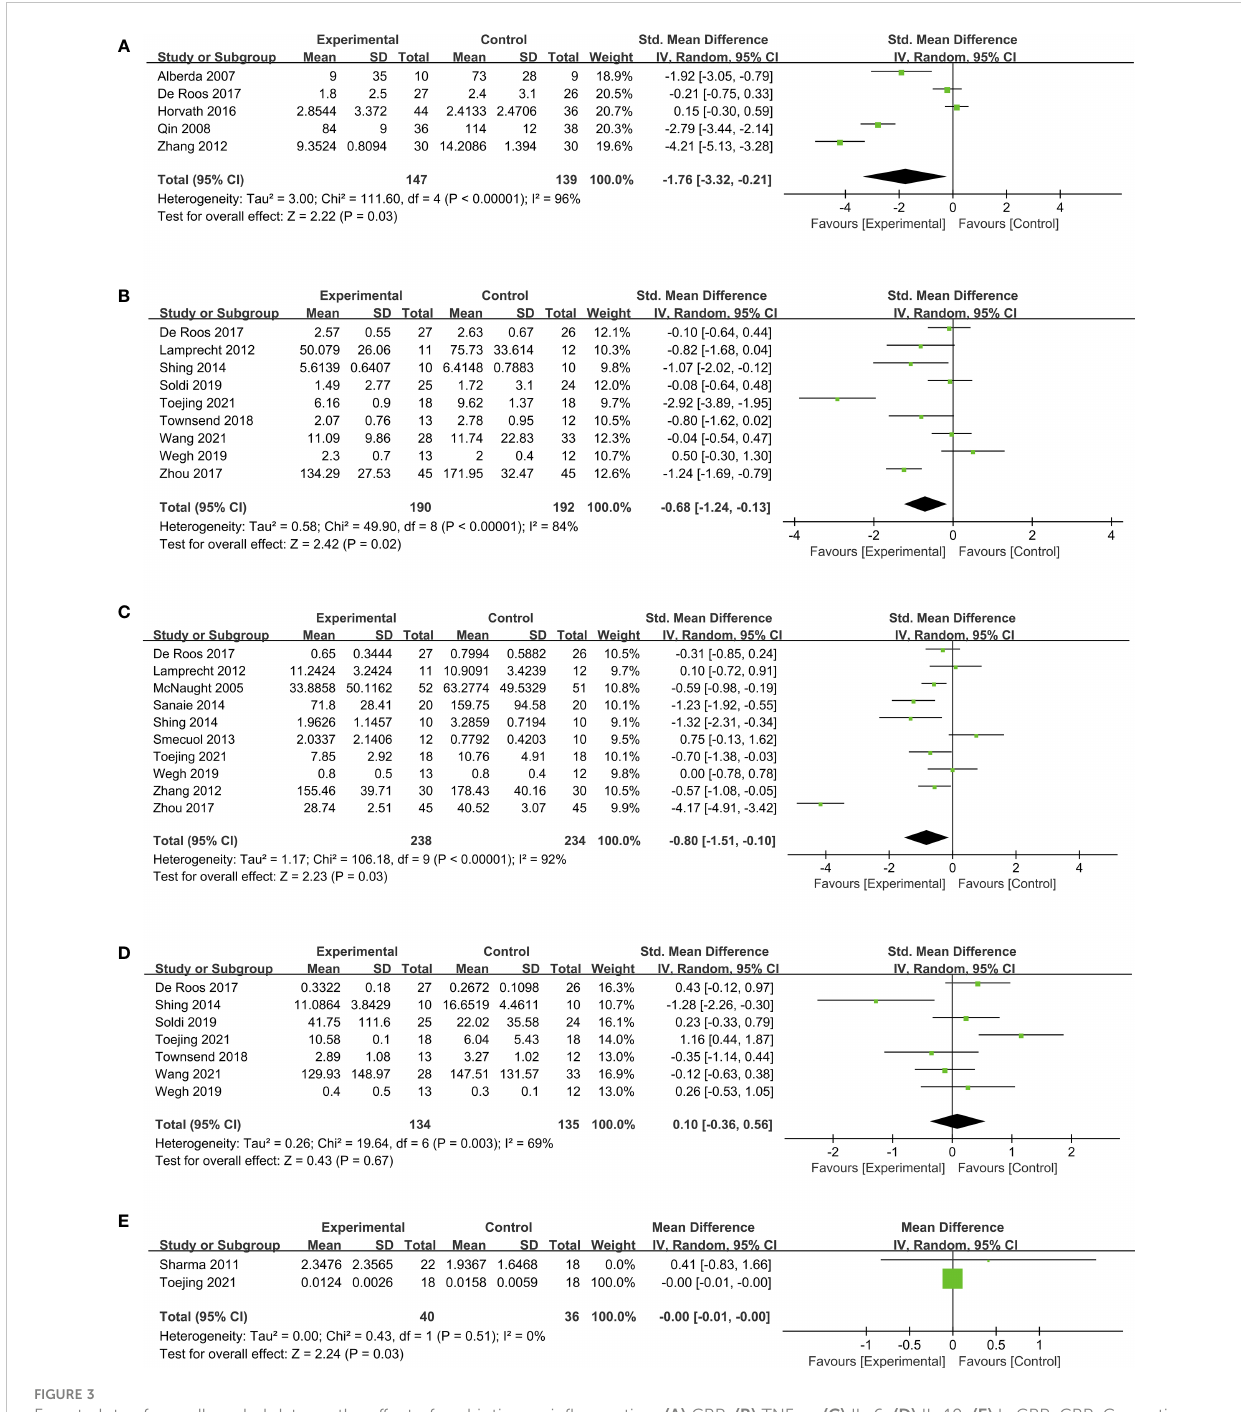
FIGURE 3 Forest plots of overall pooled data on the effect of probiotics on in fl ammation. (A) CRP, (B) TNF- a , (C) IL-6, (D) IL-10, (E) hsCRP. CRP, C-reactive protein; hsCRP, high-sensitivity C-reactive protein; IL-6, interleukin 6; IL-10, interleukin 10; TNF- a : tumor necrosis